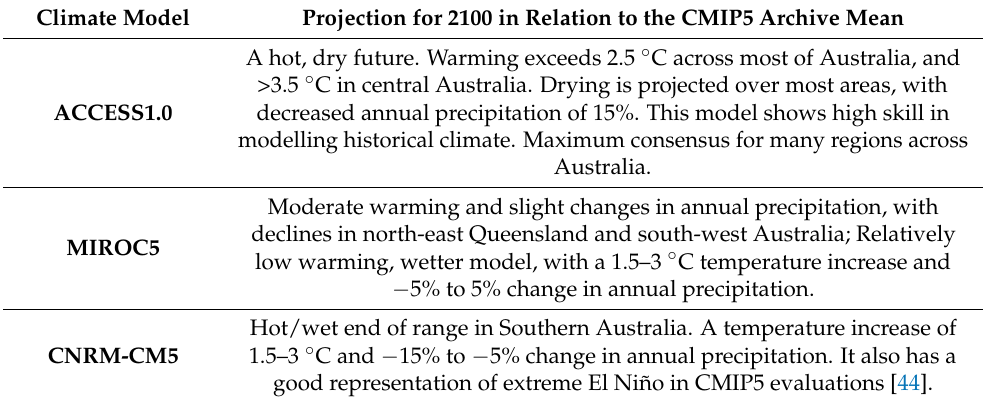
Table 2. Climate models selected to represent a range of plausible